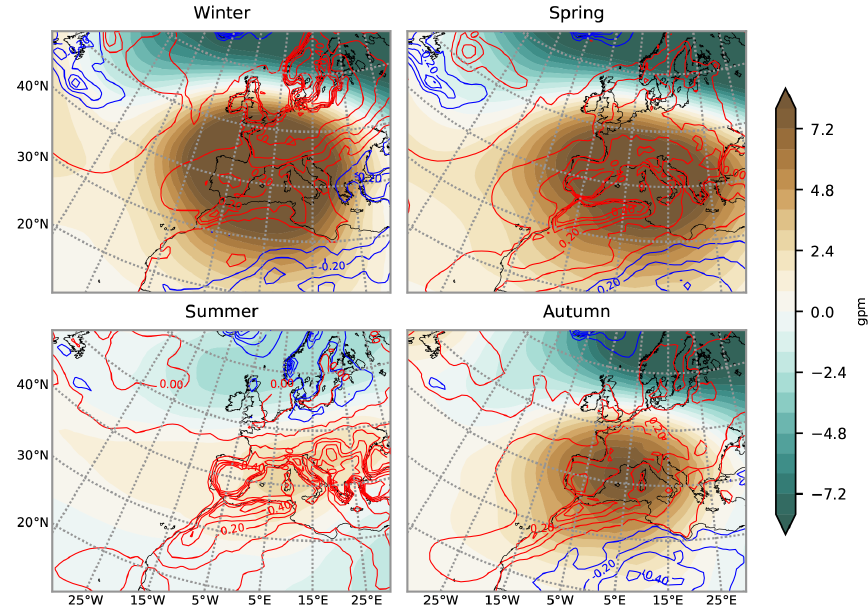
Figure 9. Mean geopotential height anomaly at 850 hPa (color shaded) and surface temperature anomaly (contours every 0 . 2 ◦ C; positive in red and negative in blue) during Mediterranean droughts for each season in the transient